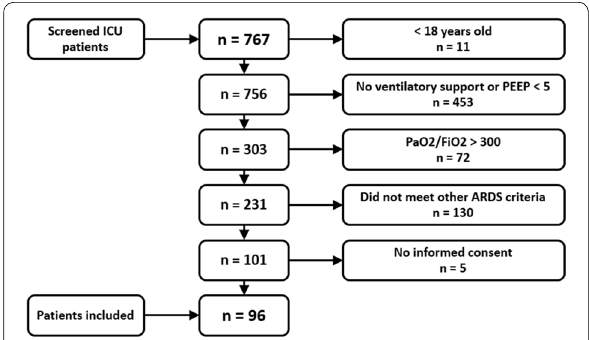
Fig. 1 Screening flowchart. PEEP: positive end‑expiratory